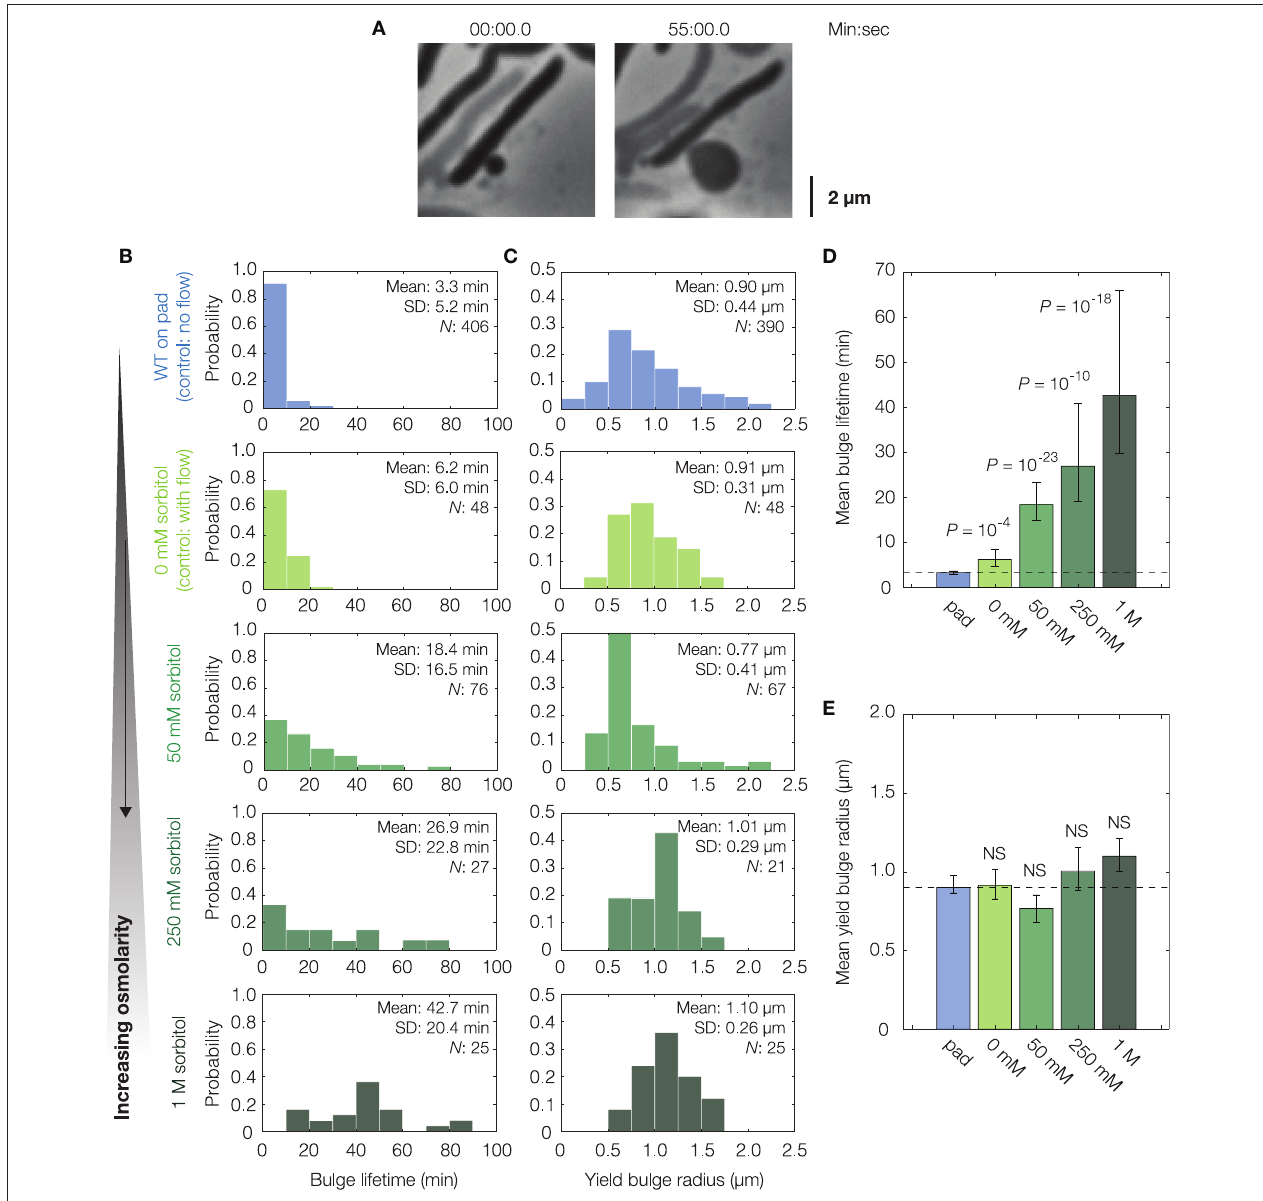
FIGURE 2 | Osmotic delay of lysis in single cells. (A) Representative bulging E. coli cell (strain MG1655) osmotically stabilized by flow of hyperosmotic media (250 mM sorbitol) after cephalexin (50 µ g/mL) treatment. For a full timelapse, see Supplementary Movie 3 ; for model predictions in cells with reduced turgor, see Supplementary Figure 2 . (B) Distributions of bulge lifetimes for wild-type E. coli cells either confined to LB-agarose pads containing cephalexin (WT, on pad) or under flow of LB containing cephalexin and sorbitol (sorbitol concentrations: 0, 50, 250 mM, and 1 M). Note that WT cells in 0 mM sorbitol differ from WT cells confined to pads in that an external flow was applied in the former. Here and below, the population mean, standard deviation (SD), and number of bulged cells ( N ) are indicated. (C) Same as (B) , but for distributions of yield bulge radii. (D) Comparison of mean bulge lifetimes between control and osmotically shocked cells. Error bars indicate 95% confidence intervals, and p -values are indicated for two-sample Kolmogorov-Smirnov tests for the difference from wild-type (whose mean value is indicated by the dashed line). (E) Same as (D) , but for mean yield bulge radii. NS, not